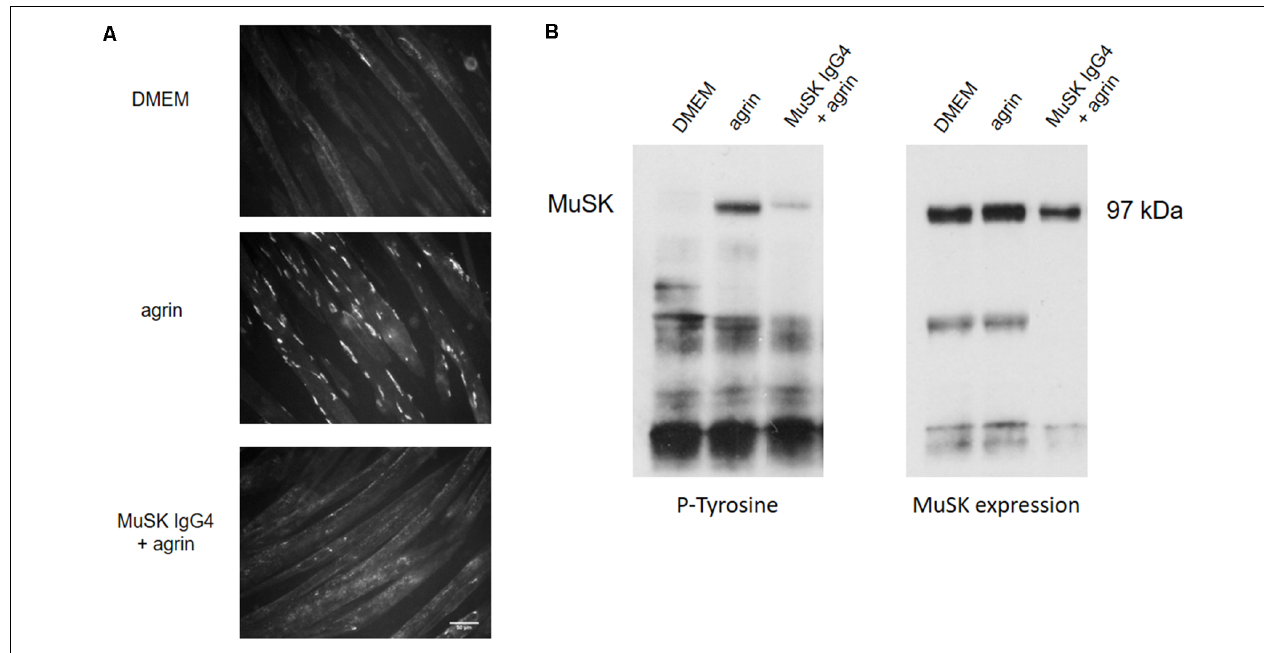
FIGURE 3 | Effects of MuSK IgG4 antibodies on AChR clustering and MuSK phosphorylation on C2C12 mouse myotubes. (A) Myotubes form few spontaneous AChR clusters (upper panel—DMEM) but, after physiological stimulation with agrin, their number increase markedly (middle panel—agrin). However, when the myotubes are exposed to MuSK antibodies, agrin-induced AChR clustering is severely impaired (lower panel—MuSK IgG4). Images are taken with an Olympus IX71 fluorescence microscope at 20 × magnifications. Scale bar represents 50 µ m. (B) Example of western blots to analyze MuSK phosphorylation. On the left, blot probed for phosphorylated tyrosine residues; on the right, the same blot is stripped and reprobed for MuSK expression. MuSK corresponds to a band at 97 kDa. MuSK phosphorylation is typically not detectable in the presence of medium only (first column—DMEM). After incubation with agrin for 45 min, MuSK phosphorylation increases markedly (second column—agrin) but this is prevented in the presence of MuSK IgG4s (third column—MuSK IgG4). Unpublished work, similar to Koneczny et al. (2013) and Huda et al.